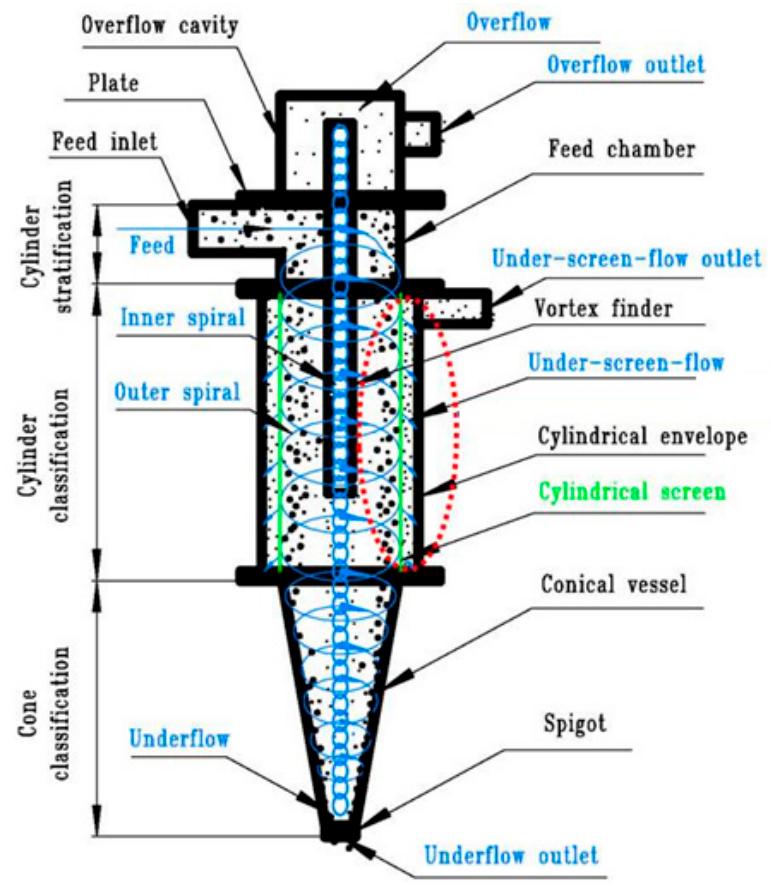
Figure 1. Schematic diagram of the three ‐ product hydro ‐ cyclone (TPHS) [18].